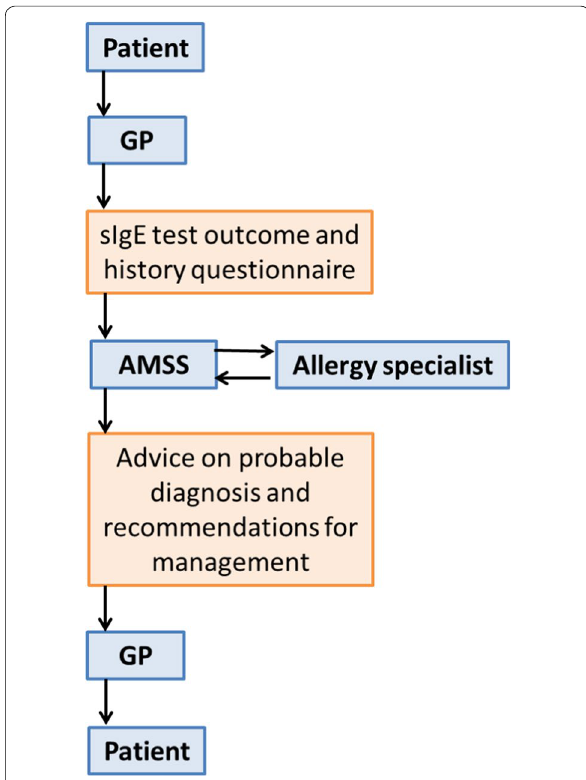
Fig. 1 Schematic representation of the allergy management